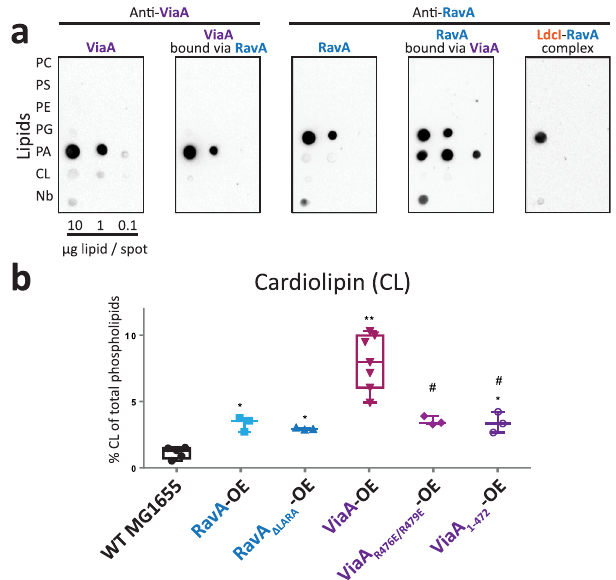
Fig. 4 | RavA and ViaA binding to speci fi c lipids, and quanti fi cation of CL in different RavA and ViaAoverexpressing strains. a Dot-blot assays using puri fi ed AviTag-ViaA-His and His-RavA, visualized using anti-ViaA and anti-RavA antibodies and a secondary HRP-antibody conjugate (PC: phosphatidylcholine, PS phospha- tidylserine, PE phosphatidylethanolamine, PG phosphatidylglycerol, PA phospha- tidicacid,CLcardiolipin).For ‘ ViaAboundviaRavA ’ or ‘ RavAboundviaViaA ’ :Lipid binding was fi rst allowed forRavA and subsequently ViaAwasadded, orvice versa. For ‘ LdcI-RavA-complex ’ ,proteinsweremixedbeforeincubationonthemembrane (see also Methods). b Quanti fi cation of cardiolipin (CL) levels by TLC and GC-FID/ MS in wild-type (WT) MG1655 E. coli cells and MG1655 E. coli cells overexpressing His-RavA, His-RavA Δ LARA , AviTag-ViaA-His, AviTag-ViaA R476E/R479E -His and AviTag- ViaA 1-472 -His, visualized by a Tukey representation showing all points within a box indicating the median, 25th and 75th percentiles and whiskers down to the mini- mumanduptothemaximumvalue.Eachpointrepresentsabiologicalrepeat,with n =3foralllinesexceptforWTwhere n =5andforViaA-OE(AviTag-ViaA-His)where n =7. The overexpressing (OE) series were compared with the control WT MG1655 series using an unpaired two-sided nonparametric Mann-Whitney test. A signi fi cant difference with the control is shown by * for p value < 0.05 ( p value = 0.0357 for ViaA 1-472 and ViaA R476E/R479E ) or ** for p value < 0.01 ( p value = 0.0025). The#indicatesasigni fi cantdifference( p value=0.0167)withViaA-OE.Sourcedata are provided as a Source Data fi